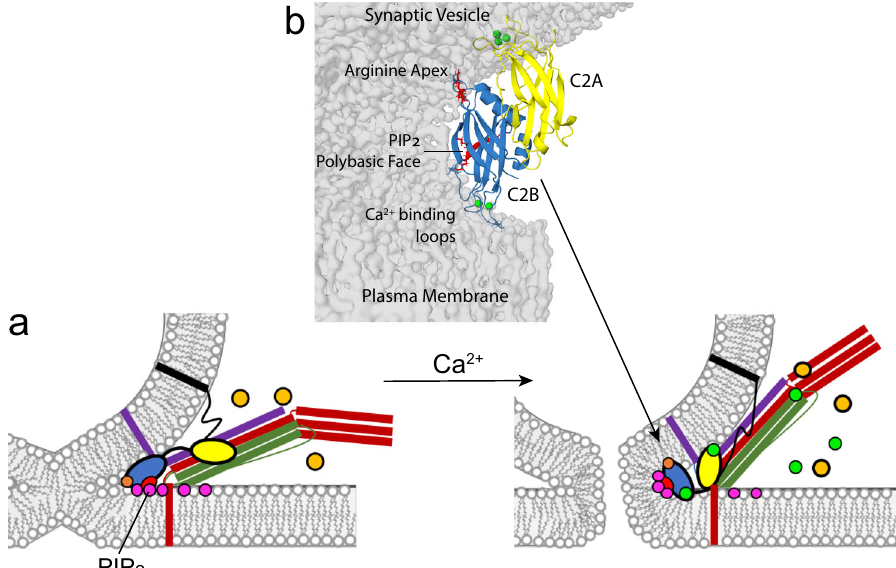
Fig. 7 Model for the membrane interactions of Syt1. In a after docking to the bilayer and in the presence of ATP/Mg 2 + (orange) the SNARE complex, syntaxin (red), SNAP-25 (green), synaptobrevin (purple), and Syt1 C2B (blue), promote partial lipid mixing by either zippering or contacting plasma membrane PIP 2 at the arginine apex (orange) and the polybasic face (red). Upon calcium in fl ux (green), Syt1 C2A inserts into the synaptic vesicle membrane, PS, and C2B reorients, binding the Ca 2 + -binding loops at a 3rd membrane contact point. The C2B domain of Syt1 might position at the site of fusion as shown in b . This orientation would sequester PIP 2 into the strained membrane stalk, further destabilizing the membrane and promoting pore opening. The C2A domain is shown inserted into the vesicle surface. This orientation of C2A is preferred in full-length Syt1 15 ; however, an interaction